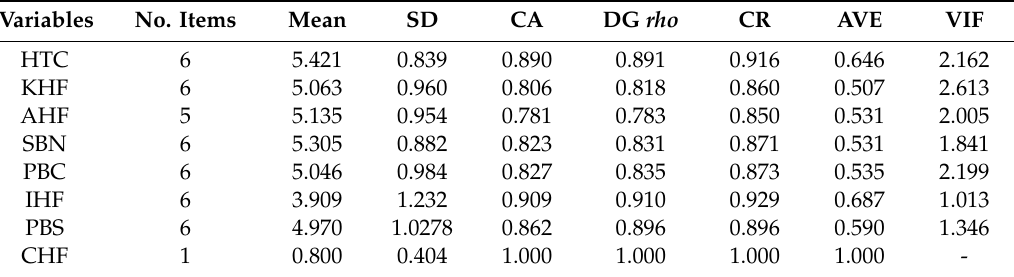
Table 2. Reliability and validity.